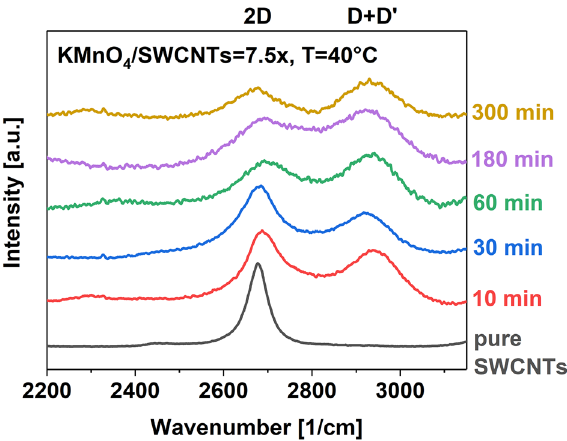
Figure 3. The evolution of 2D and D + D features for pure SWCNTs and the oxidation products carried out using the specified